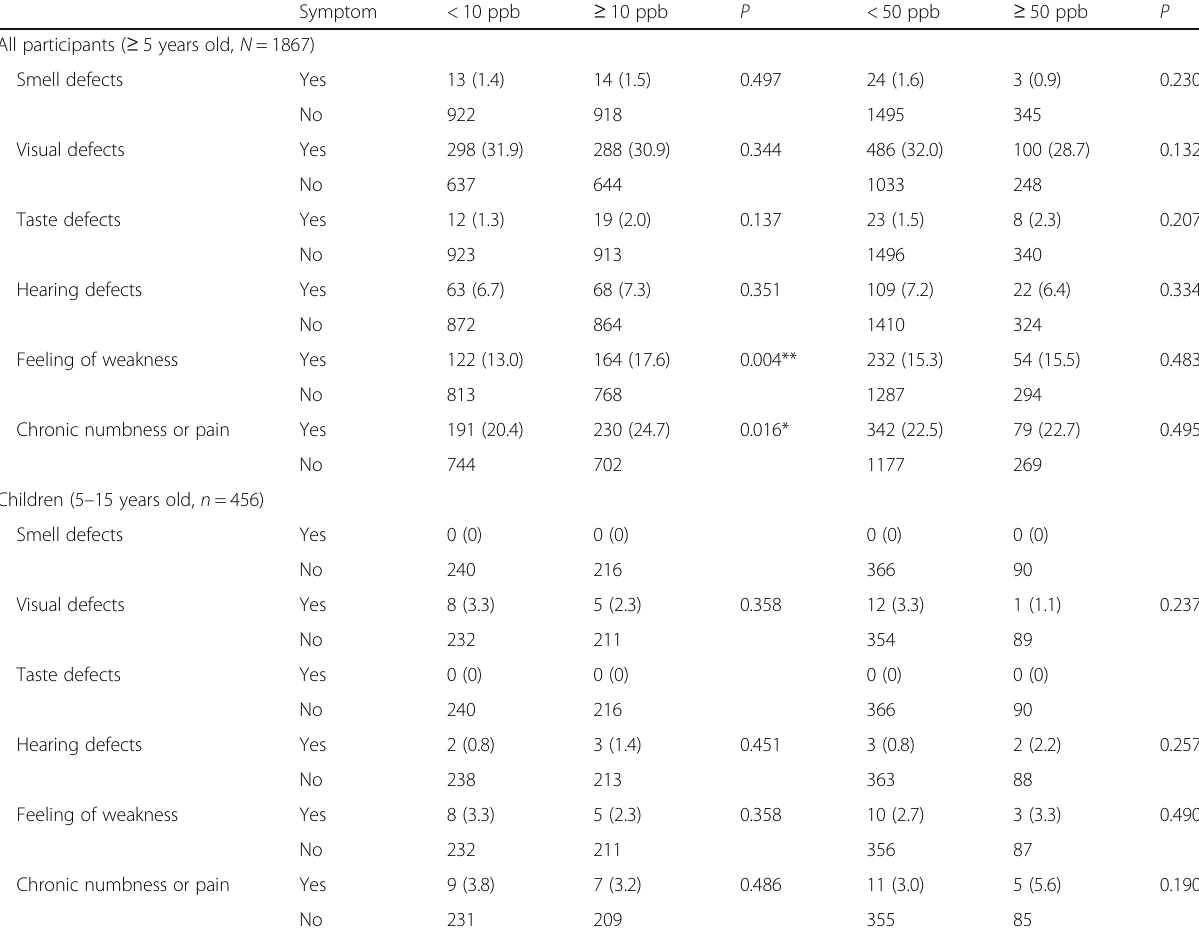
Table 2 Additional analyses to calculate the ACDW threshold for the occurrence of subjective neurological symptoms Symptom < 10 ppb ≥ 10 ppb P < 50 ppb ≥ 50 ppb P All participants ( ≥ 5 years old, N = 1867) Smell defects